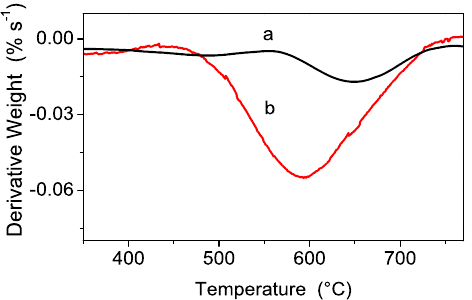
Figure 4. DTG curves of hydrolyzed ( a ) and pristine ( b ) powders.